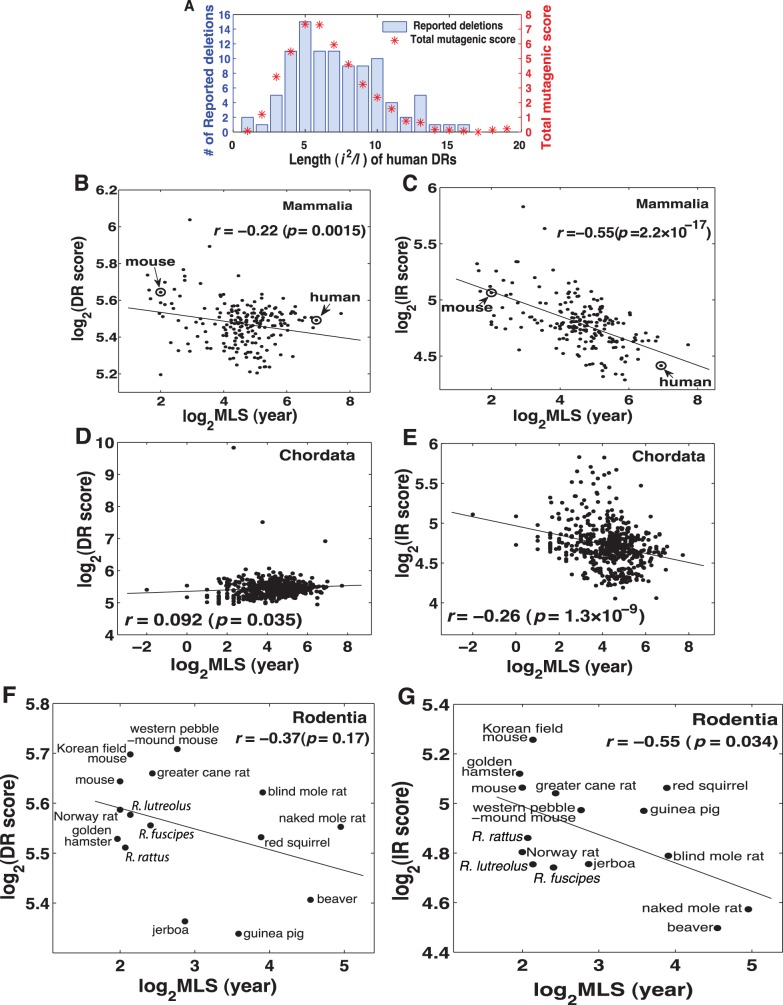
Inverted repeats (IRs) show stronger negative correlation with maximum lifespan (MLS) than direct repeats (DRs).(A) The mutagenic score calculated as  where i is the number of identical matches in l bps for each DR length, has a good fit with the number of experimentally reported human mtDNA deletions. The human mtDNA deletions are from MITOMAP database [30]. (B, C) The correlation between total mutagenic score, calculated as a sum of mutagenic scores of all DR (B) and IR (C) lengths for each species, and MLS within mammals. (D, E) The correlation between total mutagenic score and MLS within Chordata. (F, G) The correlation within Rodentia. R., Rattus.